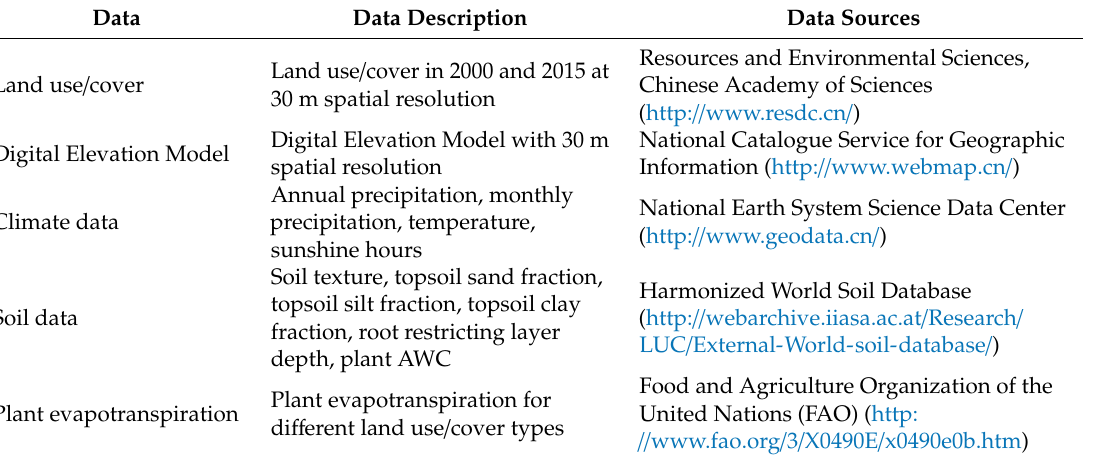
Figure 1. Location of the study area. Table 1. Description of the study data for the InVEST model.